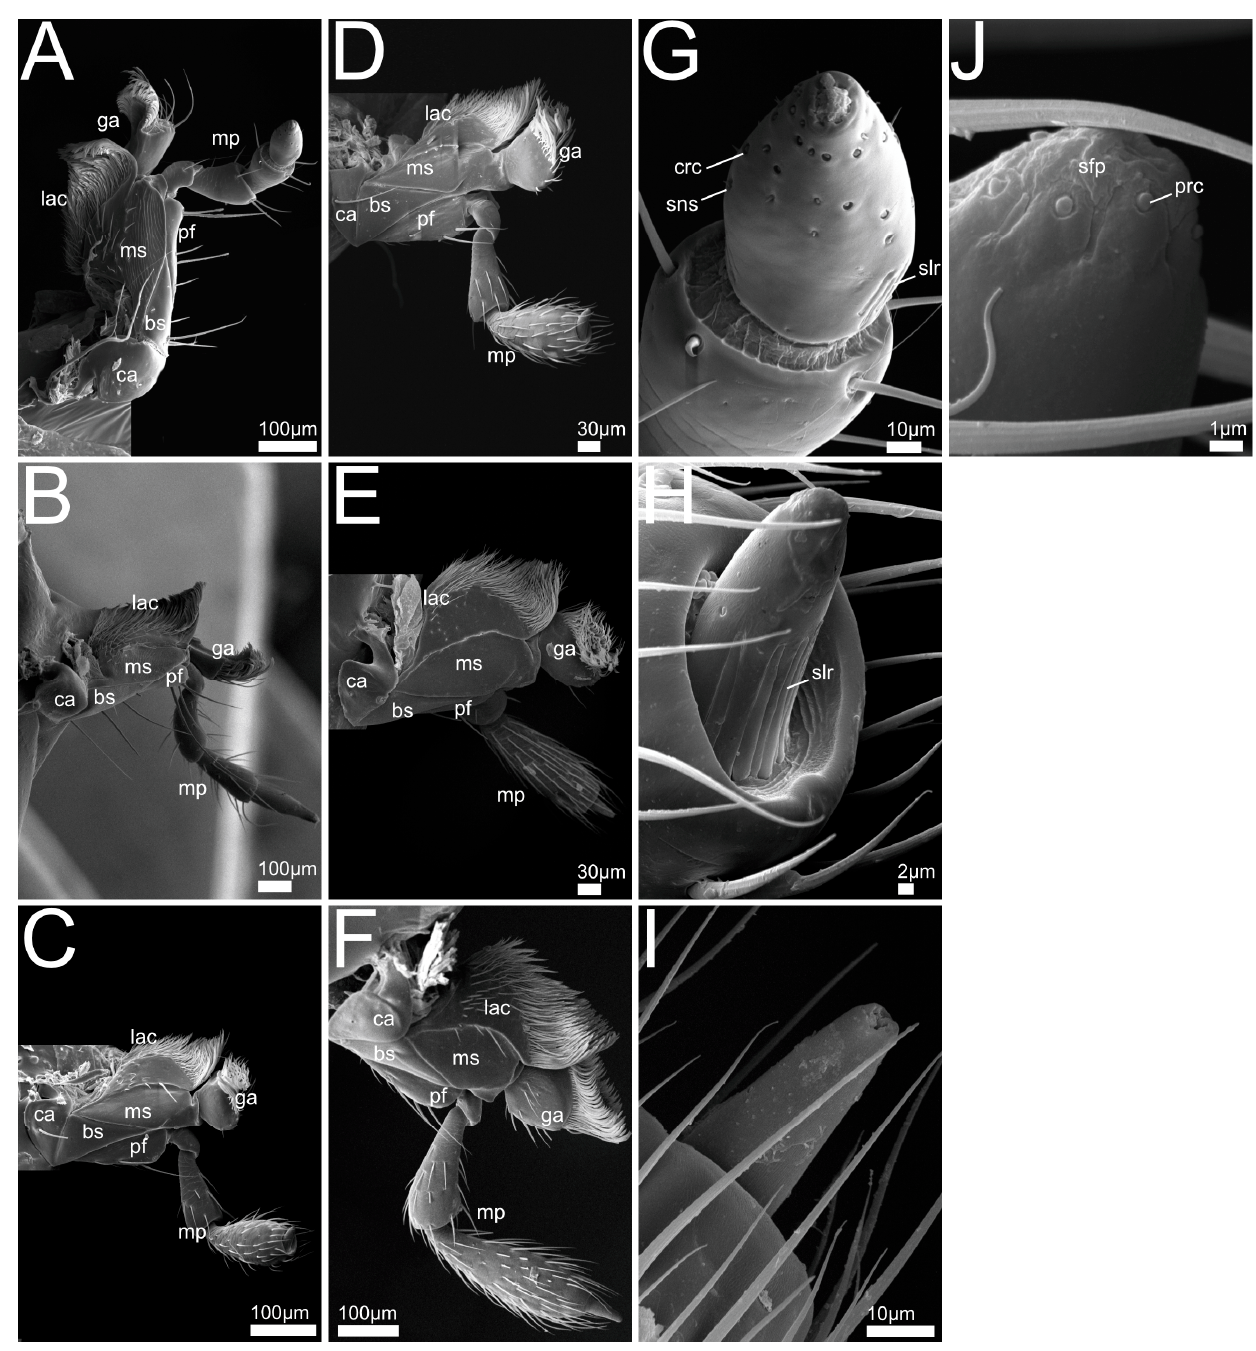
Figure 11. SEM views of Xantholinini, Othiini and Stilicina maxilla. Images A – F ventral aspect of maxilla, G–J with detailed views of apical palpomeres and receptors. ( A ) Gyrohypnus fracticornis ; ( B ) Othius punctulatus ; ( C ) Rugilus erichsonii ; ( D ) R. mixtus ; ( E ) R. orbiculatus ; ( F ) R. rufipes ; ( G ) G. fracticornis , apical segment of maxillary palp; ( H ) R. erichsonii , apical segment of maxillary palp; ( I ) R. orbiculatus , apical segment of maxillary palp; ( J ) R. mixtus , apical receptor bundle of maxillary palp. Abbreviations: bs: basistipes; ca: cardo; crc: campaniform receptor; ga: galea; lac: lacinia; slr: slit-like receptors; ms: mediostipes; mp: maxillary palp; pf: palpifer; prc: papilliform receptor; sfp: soft pad; sns: sensilla.